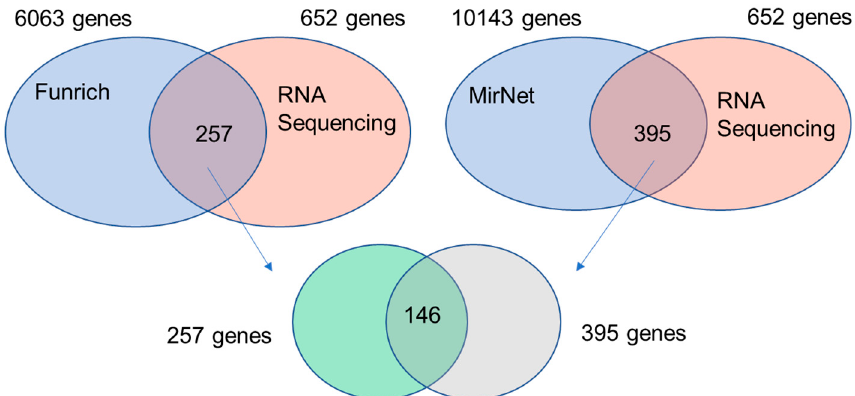
Figure 3. Venn diagram analysis indicating the identification of shared miRNAs-targeted protein-coding genes. Blue arrows indicate the 257 genes and 395 genes in the lower panel were from the intersected genes between Funrich and RNA sequencing, and miRNet and RNA sequencing respectively.